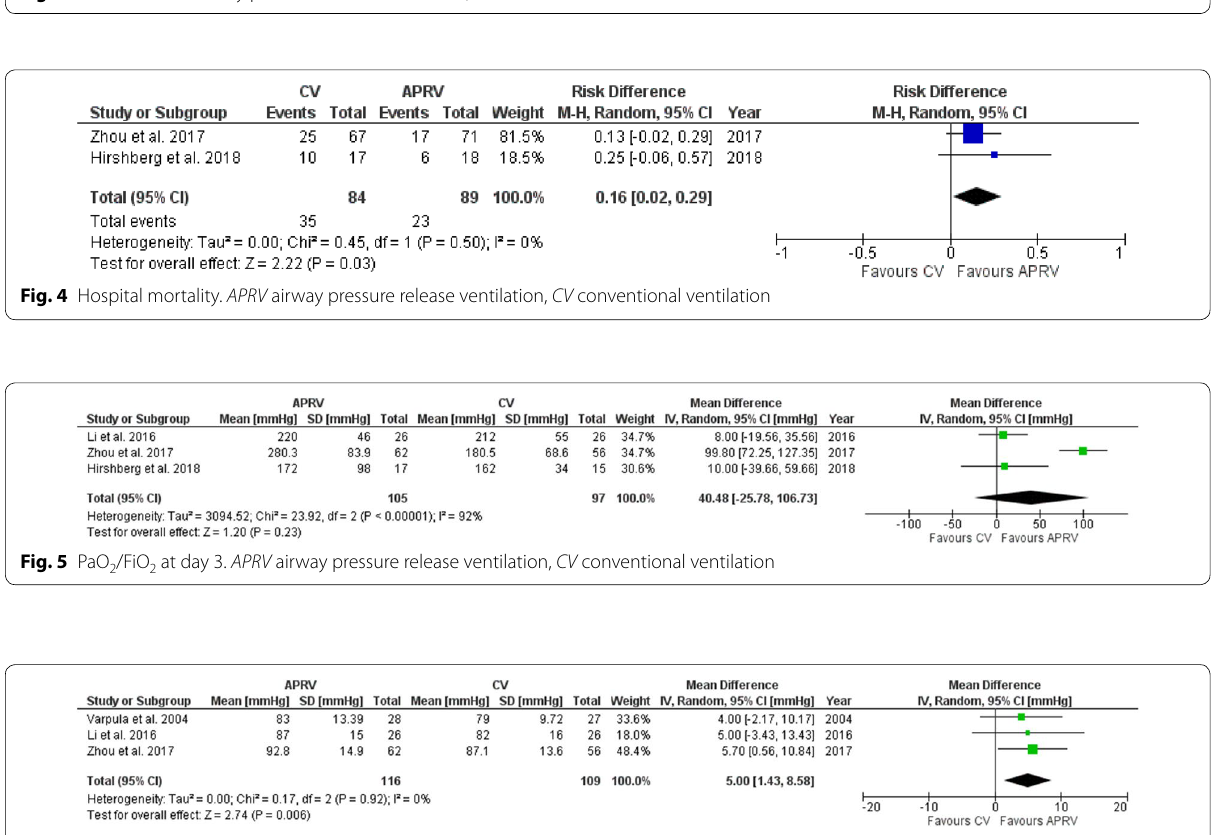
Fig. 3 ICU LOS. APRV airway pressure release ventilation, CV conventional ventilation